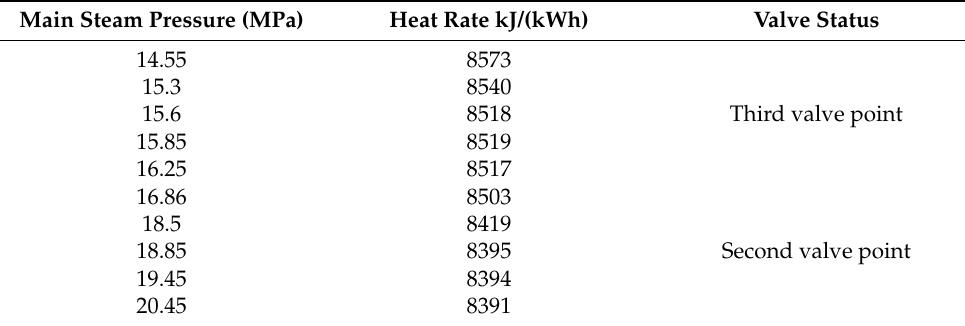
Table 4. Heat rate of unit under sliding pressure operation at 550 MW.